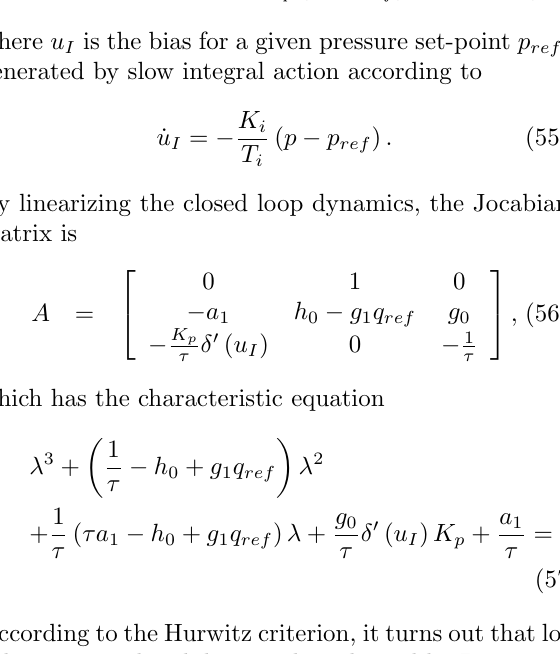
Figure 3: Simulations illustrating stabilization in the unstable region using backstepping.